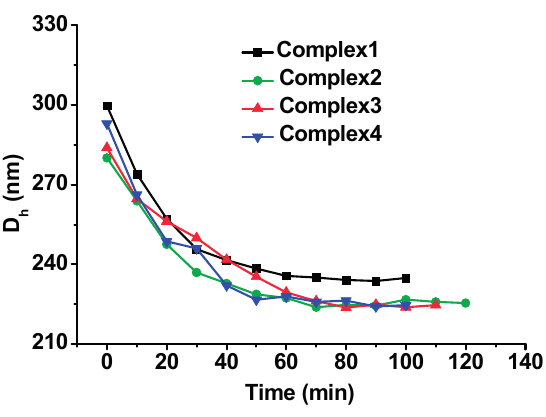
Figure 9. Droplet size changes of the four complex emulsions during the SSPS digestion by pectinase at pH 5 and 25 ° C.